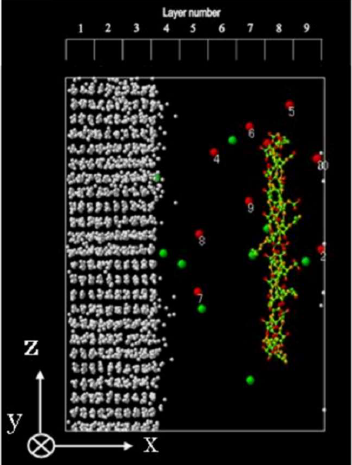
Figure 1. The computational domain with an ice layer with prism faces. White dots show oxygen atoms of water molecules in the bulk ice region (water molecules in the liquid region are not shown). Red dots and green dots show sodium ions and chloride ions, respectively. Many dots connected show the HPLC6 model. Nine layers are defined in the computational domain.